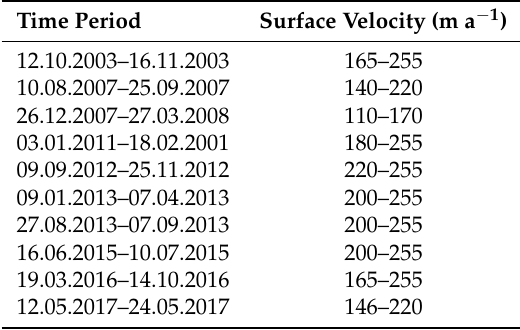
Table 3. Time period and the mean value of the accelerations (m a − 1 ) of Trango Glacier as extracted along the profile shown in Figure 1. Note that the date refers to the acquisition date of the SAR pair used for the calculation of the displacement